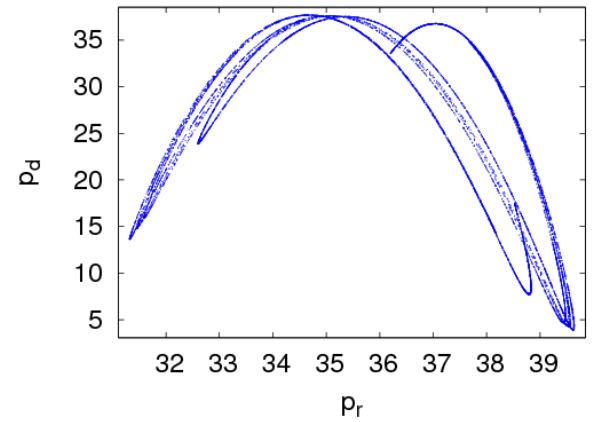
Figure 6. Chaos attractors of dynamic System (7) with α 1 = 0.0165 and α 2 = 0.008.